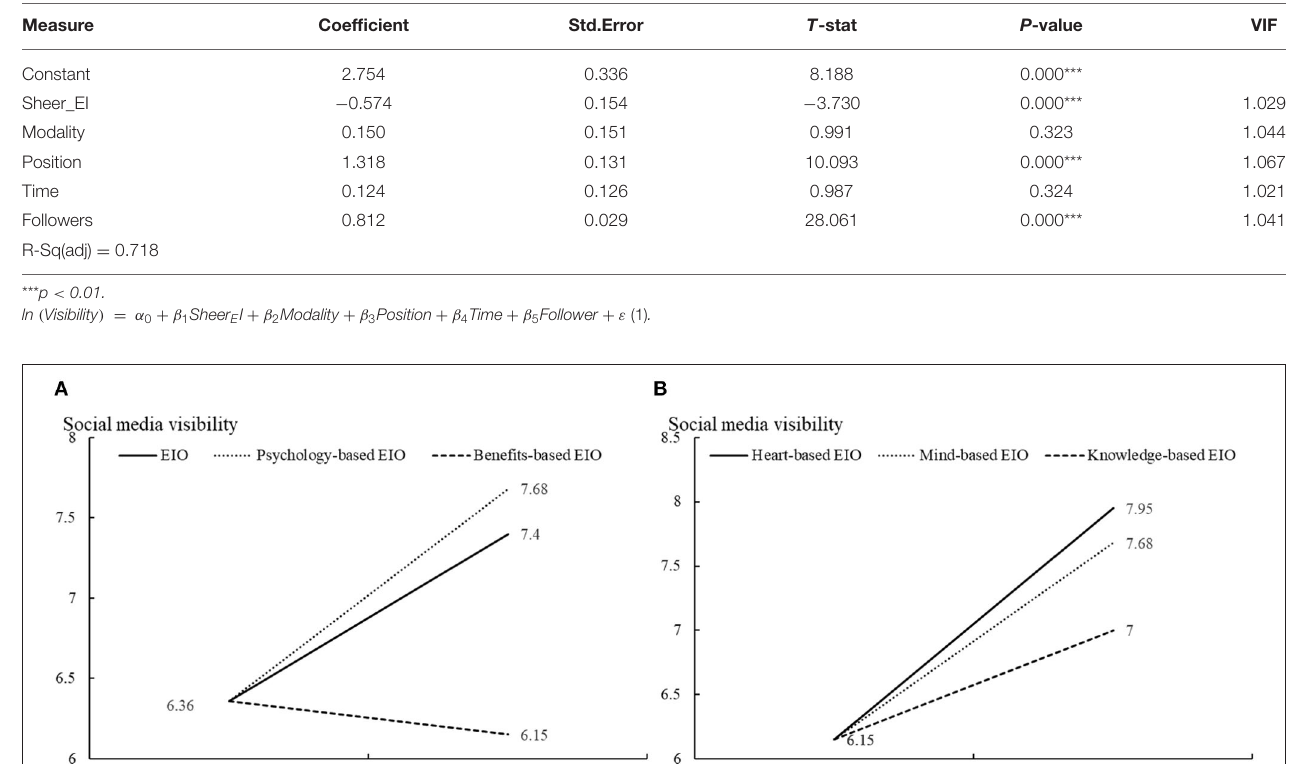
TABLE 5 | Results of the regression analysis of model (1).